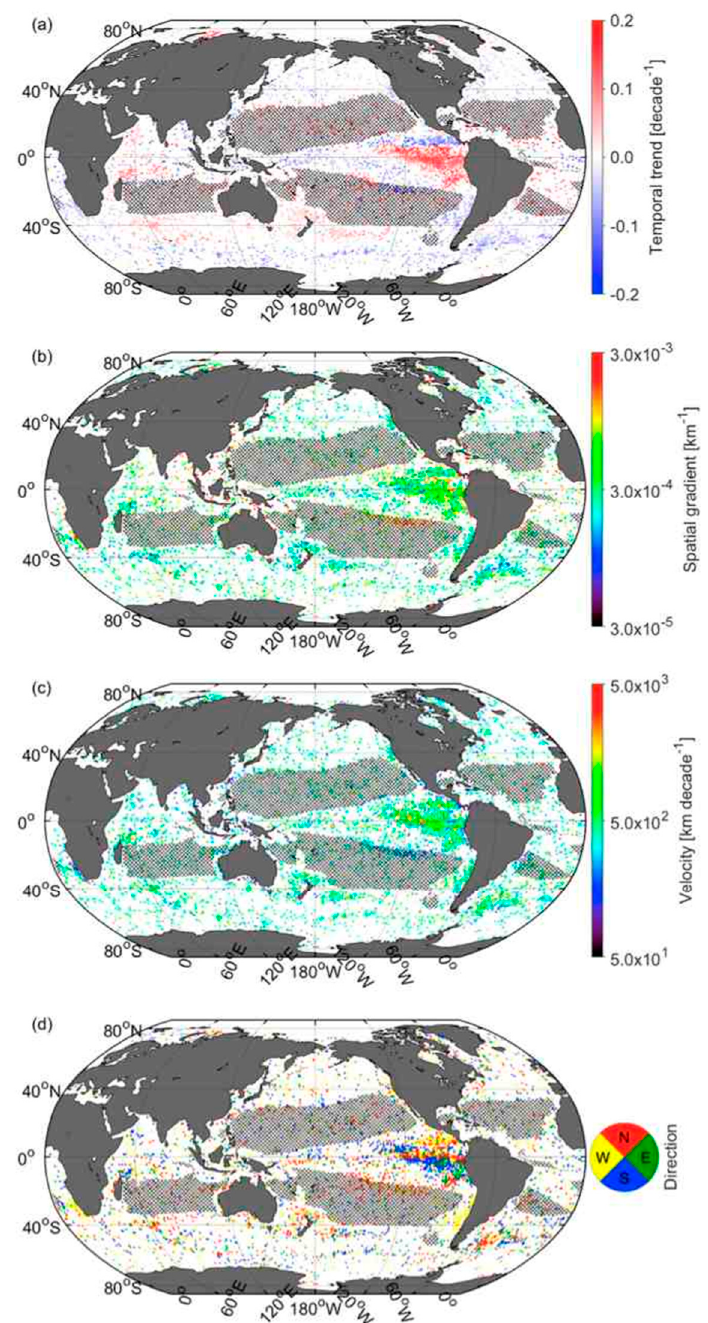
Figure 8. Global distribution of: ( a ) temporal trend; ( b ) spatial gradient; ( c ) velocity; and ( d ) direction of CSD slope. White shows the area with non-significant ( p > 0.05) temporal trend for the period 2003–2015. Cross-hatching shows areas of climatological a ph (443) = 0.01, where the CSD slope values contain uncertainties because of the low estimation accuracy of the QAA-derived a ph ( λ ).